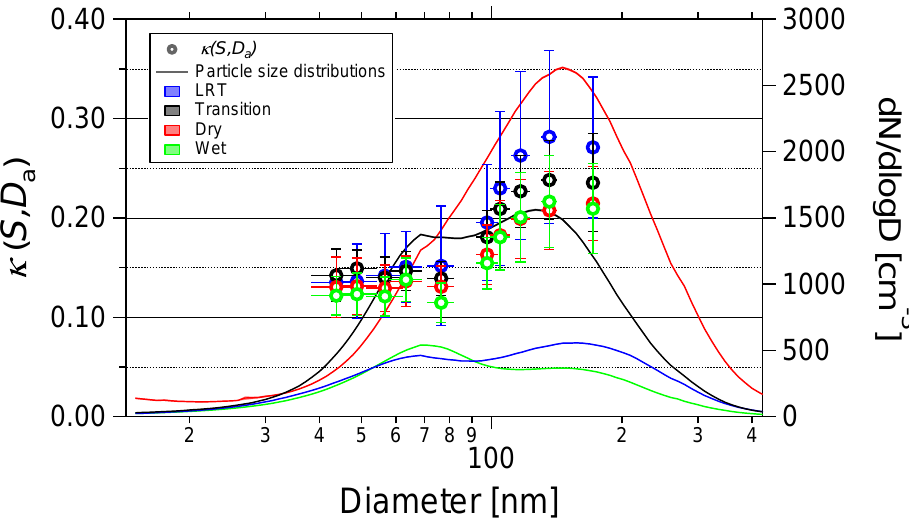
Figure 6. Size dependence of the hygroscopicity parameter κ ( S , D a ) subdivided into seasonal periods of interest (color coding) as specified in Sect. 3.3. Values of κ ( S , D a ) for every S level are plotted against their corresponding midpoint activation diameter D a ( S ) (left axis). For κ ( S , D a ) , the error bars represent 1 standard deviation. For D a ( S ), the experimentally derived error is shown. In addition, the average number size distributions for the seasonal periods of interest are shown (right axis). The standard error of the number size distributions is indicated as shading, which is very small and therefore hardly perceptible in this representation due to the large number of scans with comparatively small variability. A clear size dependence and seasonal trends in κ ( S , D a ) levels can be observed. The averaged number size distributions show very pronounced seasonal